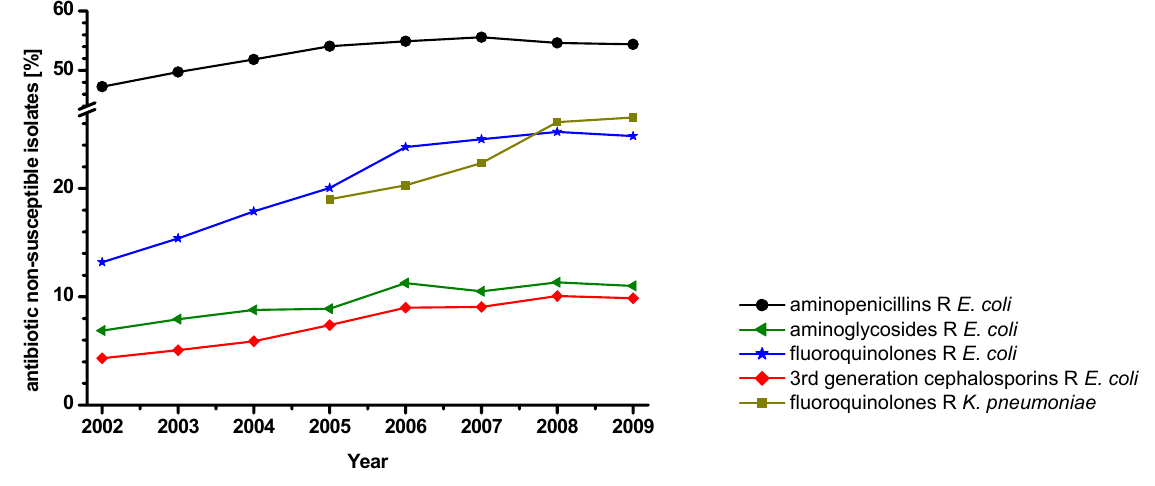
Figure 1. Progress of selected resistant bacterial strains in Central and Southern Europe between 2002 and 2009. The amount of resistant isolates increased slowly but constantly over the